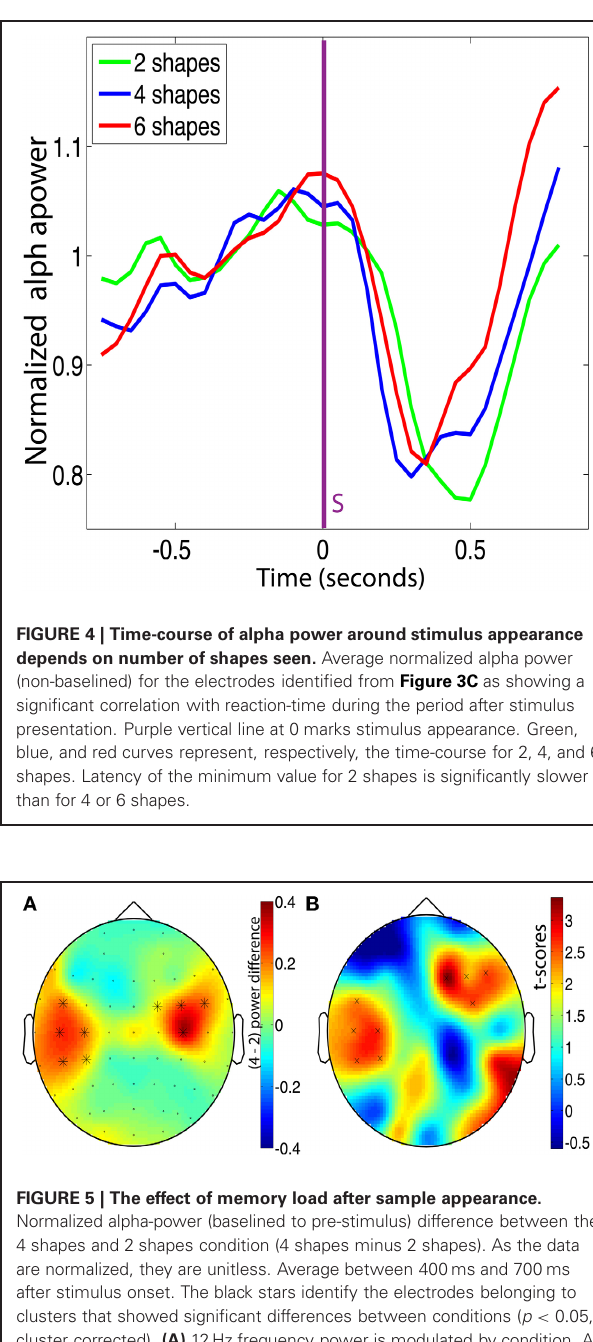
(between 400 ms and 700 ms). Two clusters of electrodes ( p < 0 . 05, cluster corrected) were found to show significant differences depending on the number of shapes during the resynchroniza- tion period (400–700 ms post-stimulus), one located in the left